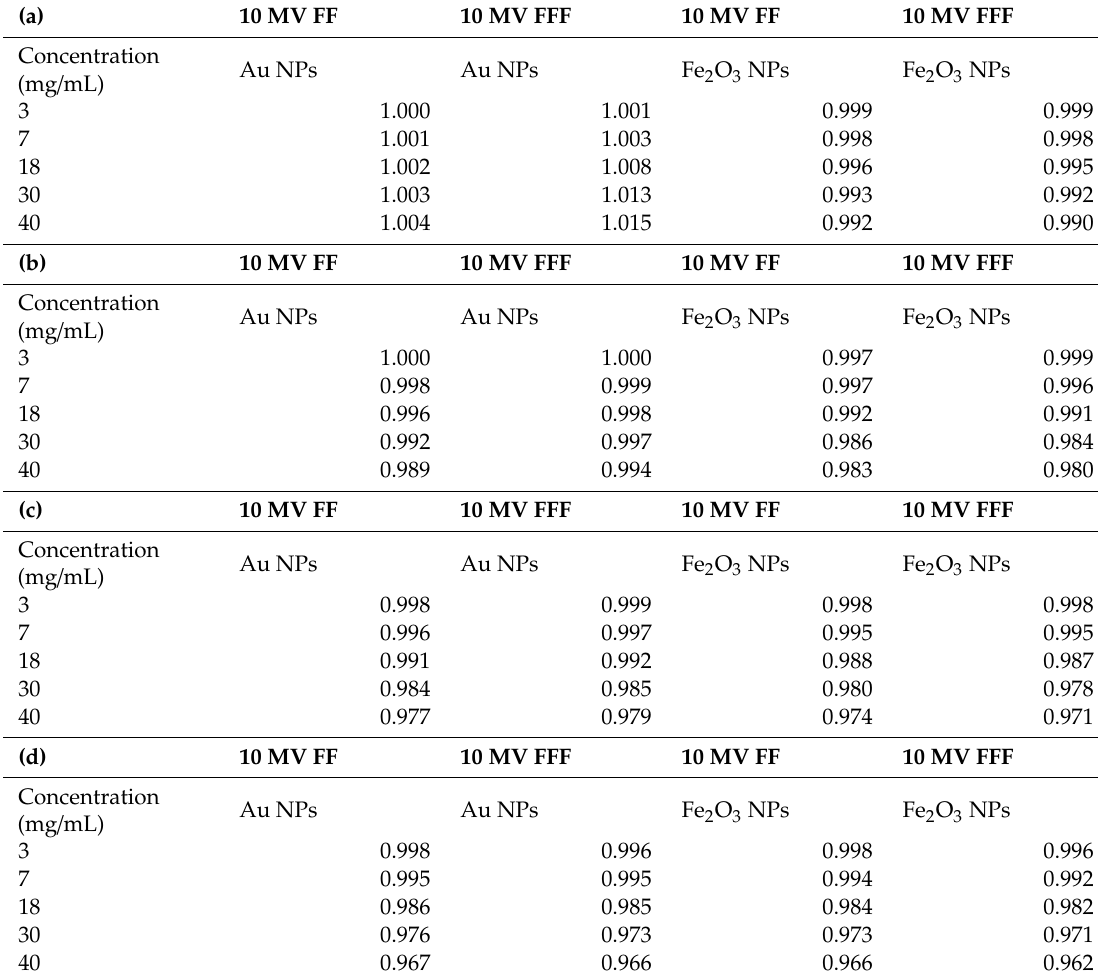
Table 1. DDERs with variations of the NP material (Au and Fe 2 O 3 ) and concentration for depth